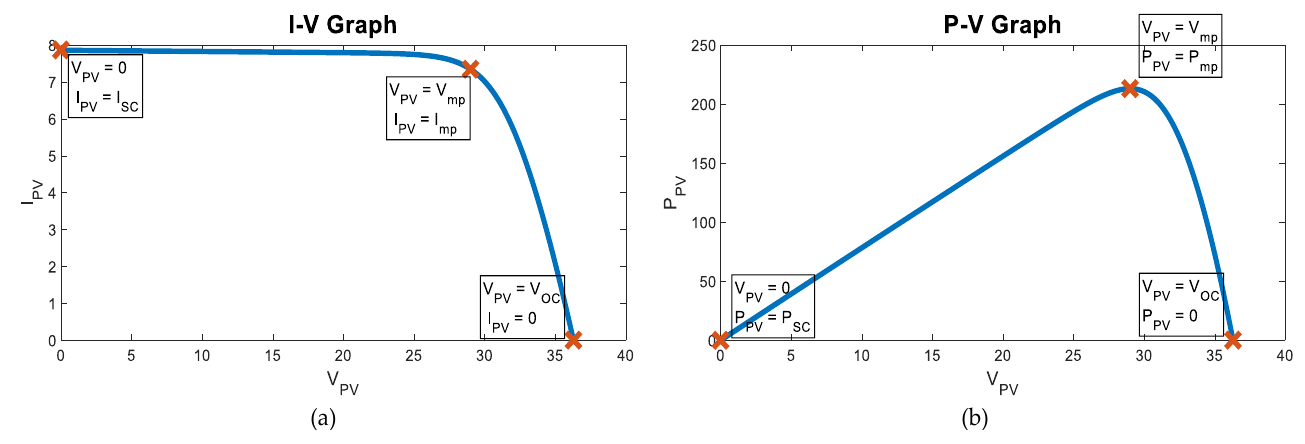
Figure 9. ( a ) I-V and ( b ) P-V characteristic curves of a PV module.